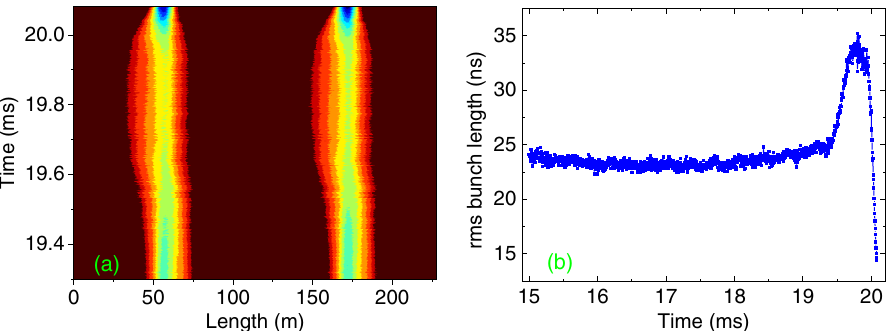
FIG. 6. Evolution of the charge distribution of the two bunches in the RCS from 19.3 ms to the extraction (a) and the evolution of the rms bunch length from 15 ms to the extraction (b) in the target-shooting